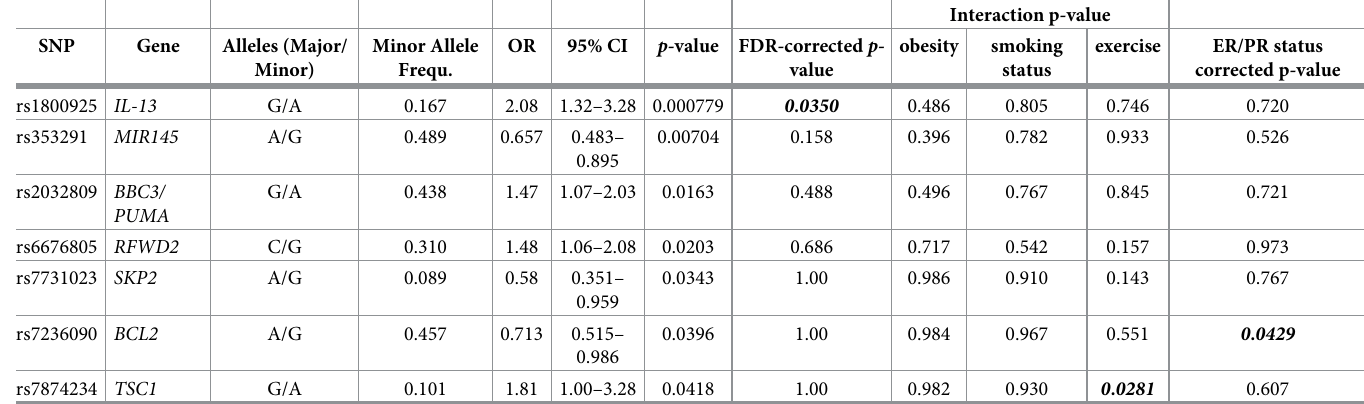
Table 3. Logistic regression and interaction analysis results for East Asian samples for SNPs with p < 0.05 before FDR.